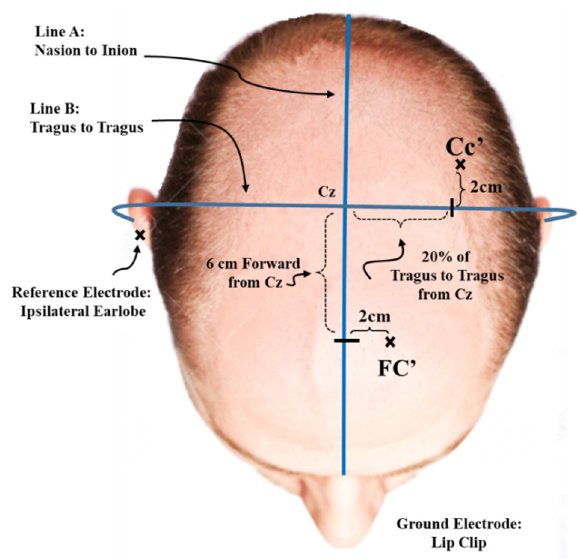
Figure 2. Schematic of cephalic site recording EEG electrode placement: According to the EEG adhesive conductive paste (type TEN20) international EEG system, the cortical locations placed contralateral to the site of stimulation: on parietal site (CC’) (20% of the subject’s tragus to tragus measurement and 2 cm posterior to contralateral to vertex or Cz), and frontal site (Fc’) (6 cm anterior and 2 cm contralateral to Cz), and with an ipsilateral earlobe reference.